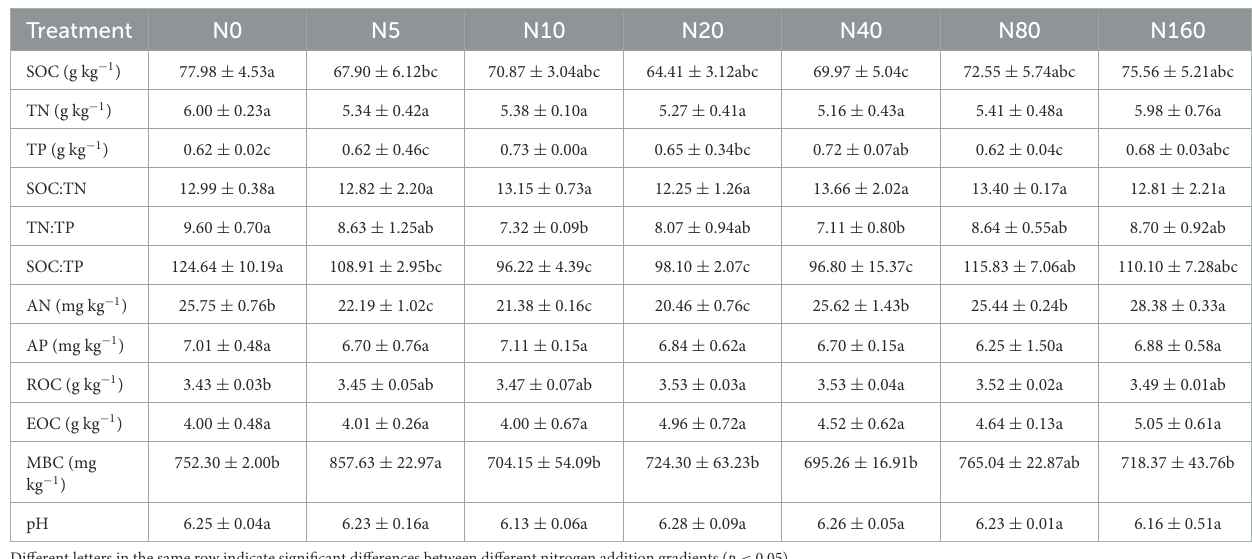
TABLE 2 Effects of nitrogen addition on soil chemical